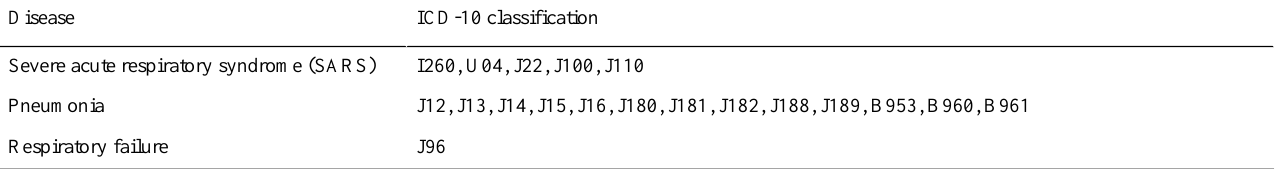
Table 2. International Statistical Classification of Diseases and Related Health Problems–10th Revision (ICD-10) classification adopted by the Transparency Portal of Civil